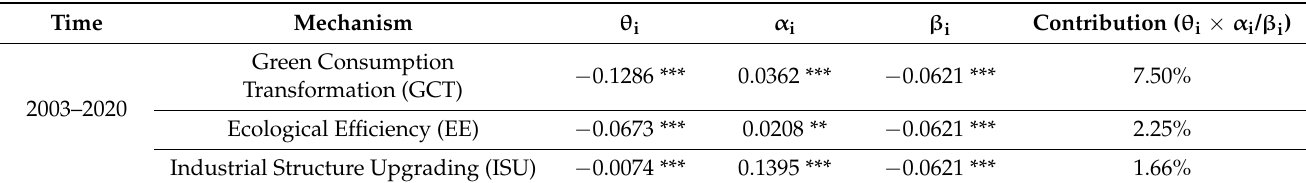
Table 9. Mechanism contribution decomposition.